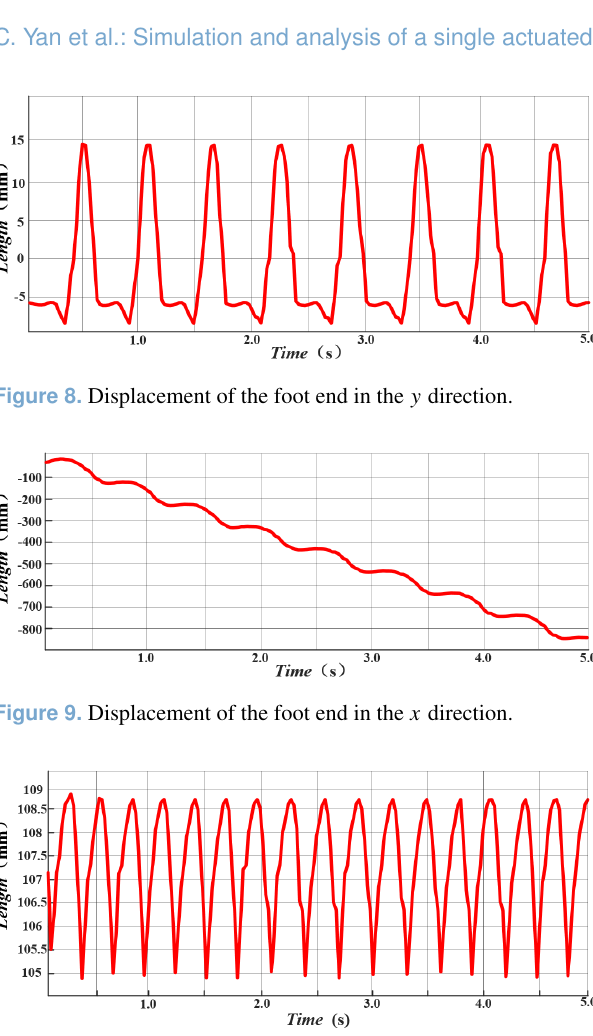
Figure 10. Displacement of the robot’s centroid along the y direc- tion.